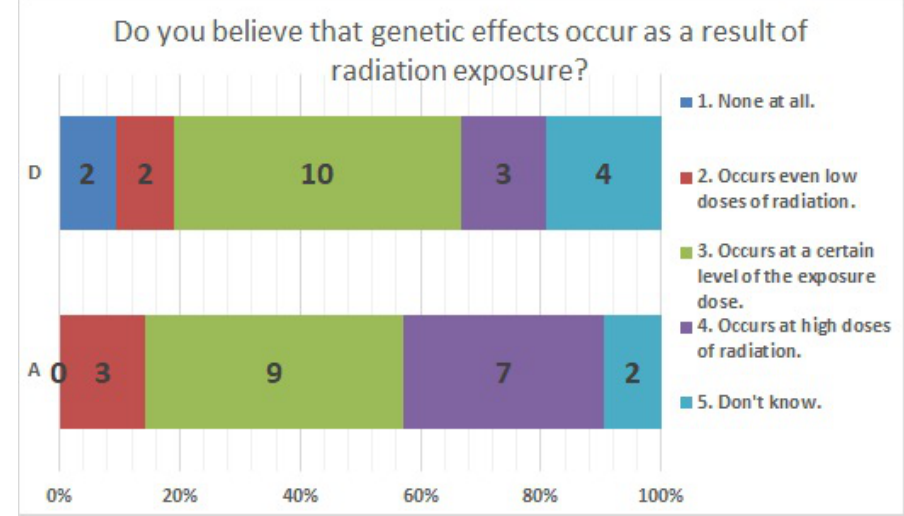
Figure 12. Responses to item No. 9